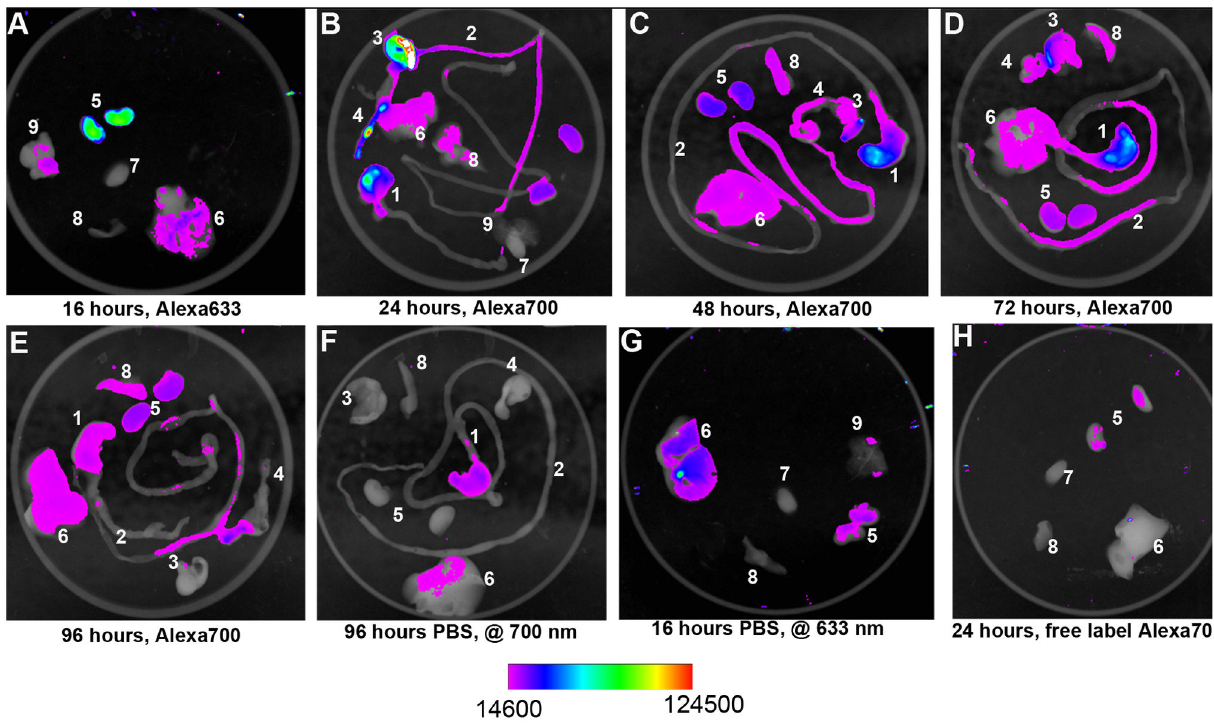
Figure 5. Labeled ricin disseminates to distal organs. Organs were excised from mice at 16 hours (A, G), 24 hours (B, H), 48 hours (C), 72 hours (D) or 96 hours (E, F) following orogastric intoxication. Alexa Fluor ® 633-labeled ricin (A), Alexa Fluor ® 700- labeled ricin (B, C, D, E), PBS (F, G), or free Alexa Fluor ® 700 label (H) was detected by fluorescence imaging as shown in; 1. stomach, 2. small intestine, 3. cecum, 4. large intestine, 5. kidneys, 6. liver, 7. heart, 8. spleen, 9. lung. *Mice that received PBS only were imaged at the same wavelength (690 nm) as mice that received AlexaFluor ® 700-labeled ricin. ** Mice that received PBS only were imaged at the same wavelength (620 nm) as mice that received AlexaFluor ® 633-labeled ricin. All PBS-treated mice had similar imaging profiles at all time